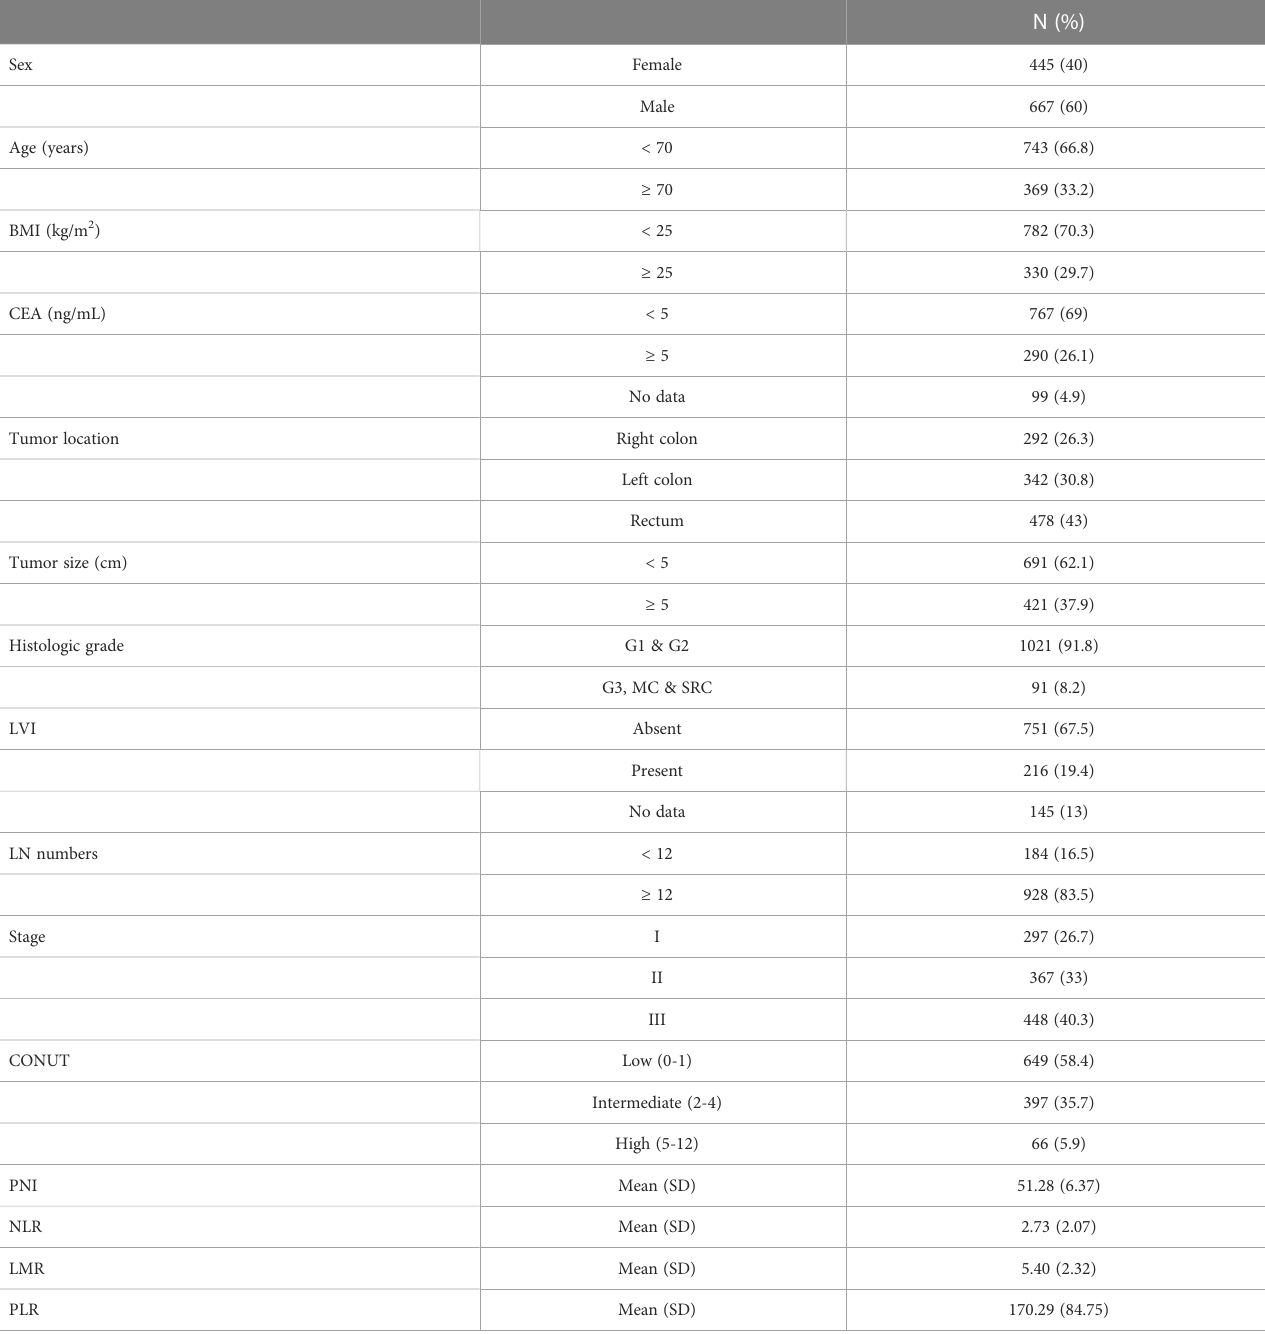
TABLE 1 Patient ’ s